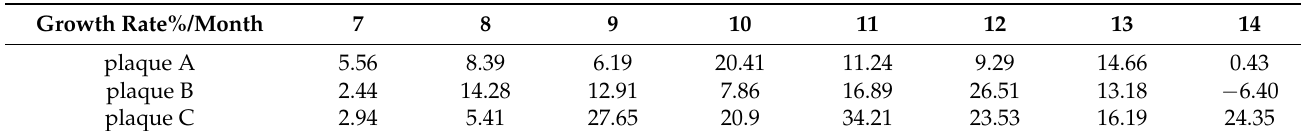
Table 1. The growth rate (%) of plaques A, B, and C per month from 7-month-old to 14-month-old mice.